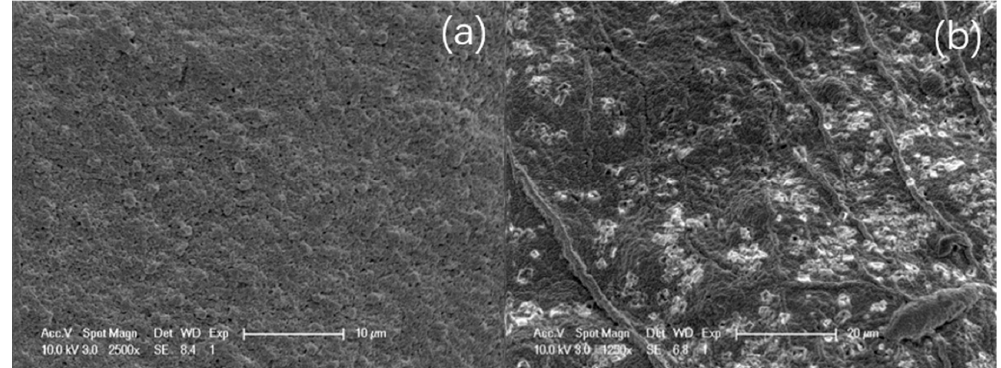
Figure 2. Scanning electron microscopy (SEM) images of the surface of the bio-microcapsules. ( a ) Magnification: 2500 × , ( b ) Magnification: 1250 × .